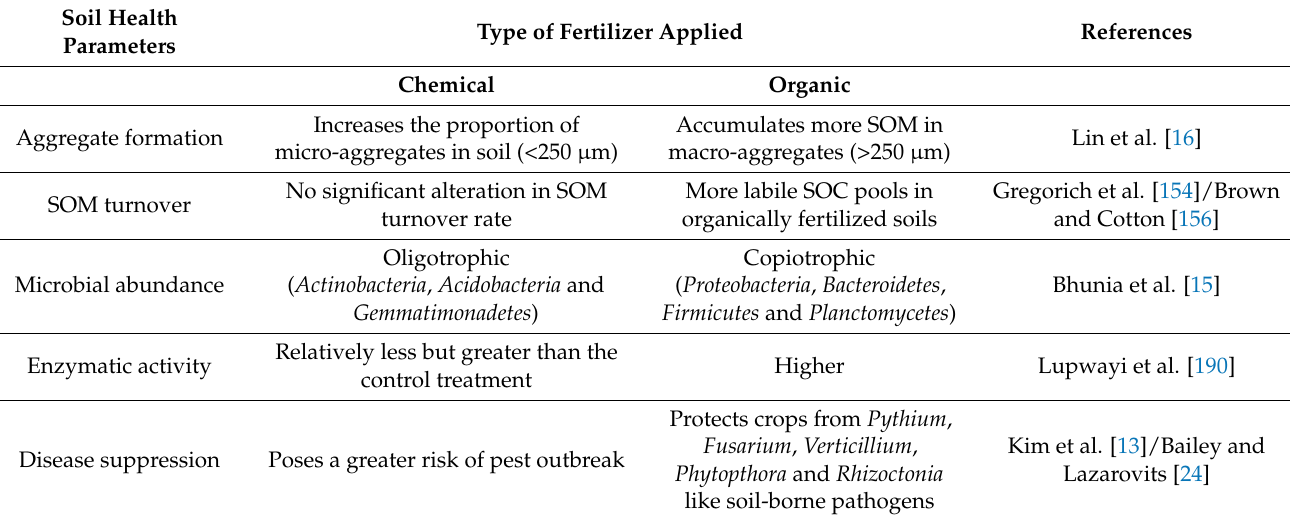
Table 3. Alteration in agro-ecosystem health under different fertilization